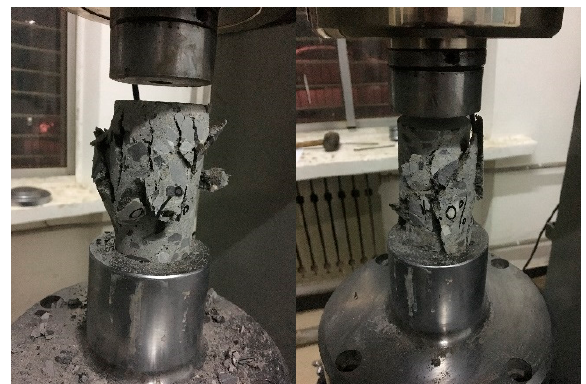
Figure 16. Typical failure modes of FRC under a dynamic load.